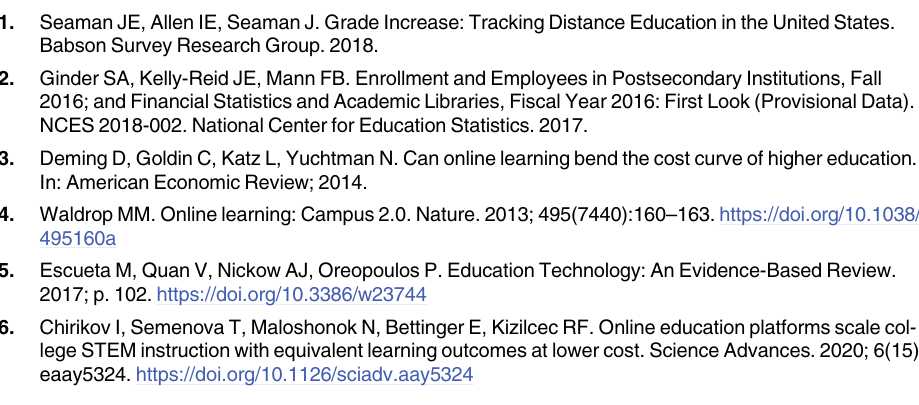
S1 Table. Empirical distributions of primary, secondary, and exploratory features coded in the Stanford sample. Mean x � , standard deviation σ , and five-number summary q